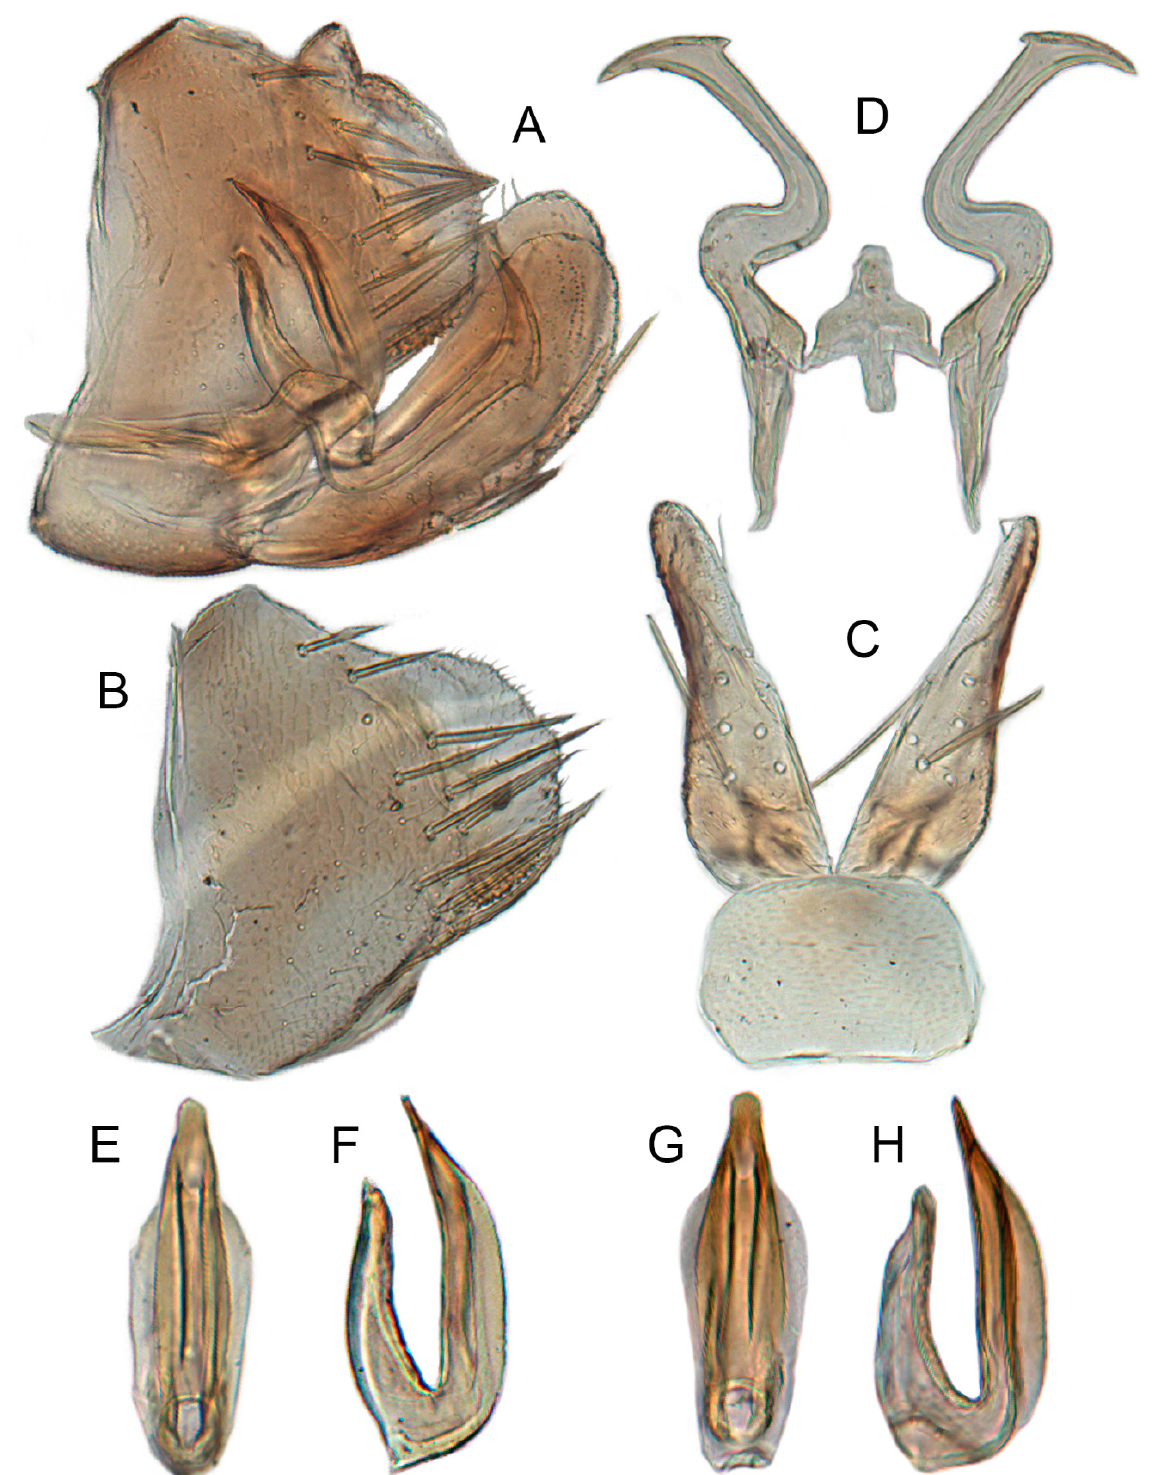
Figure 2. Xestocephalus asper Linnavuori, 1969. ( A ) Male genital capsule, lateral view; ( B ) pygofer lobe, lateral view; ( C ) subgenital plates and valve, ventral view; ( D ) style and connective, ventral view; ( E , G ) aedeagus, posterior view; ( F , H ) aedeagus, lateral view. ( A – F ) from Chaiyaphum and ( G , H ) from Chiang Mai. Xestocephalus guttatus Matsumura, 1902a: 403, Figure 29 [66]; Melichar, 1903b: 206, 207 [67]; Melichar, 1905: 303 [68]; Oshanin 1906a: 139 [69]; Distant, 1908g: 349, 350, Figure 221 [28]; Oshanin 1910: 166 [70]; Oshanin 1912a: 108 [71]; Matsumura 1914: 203, 204 [59];